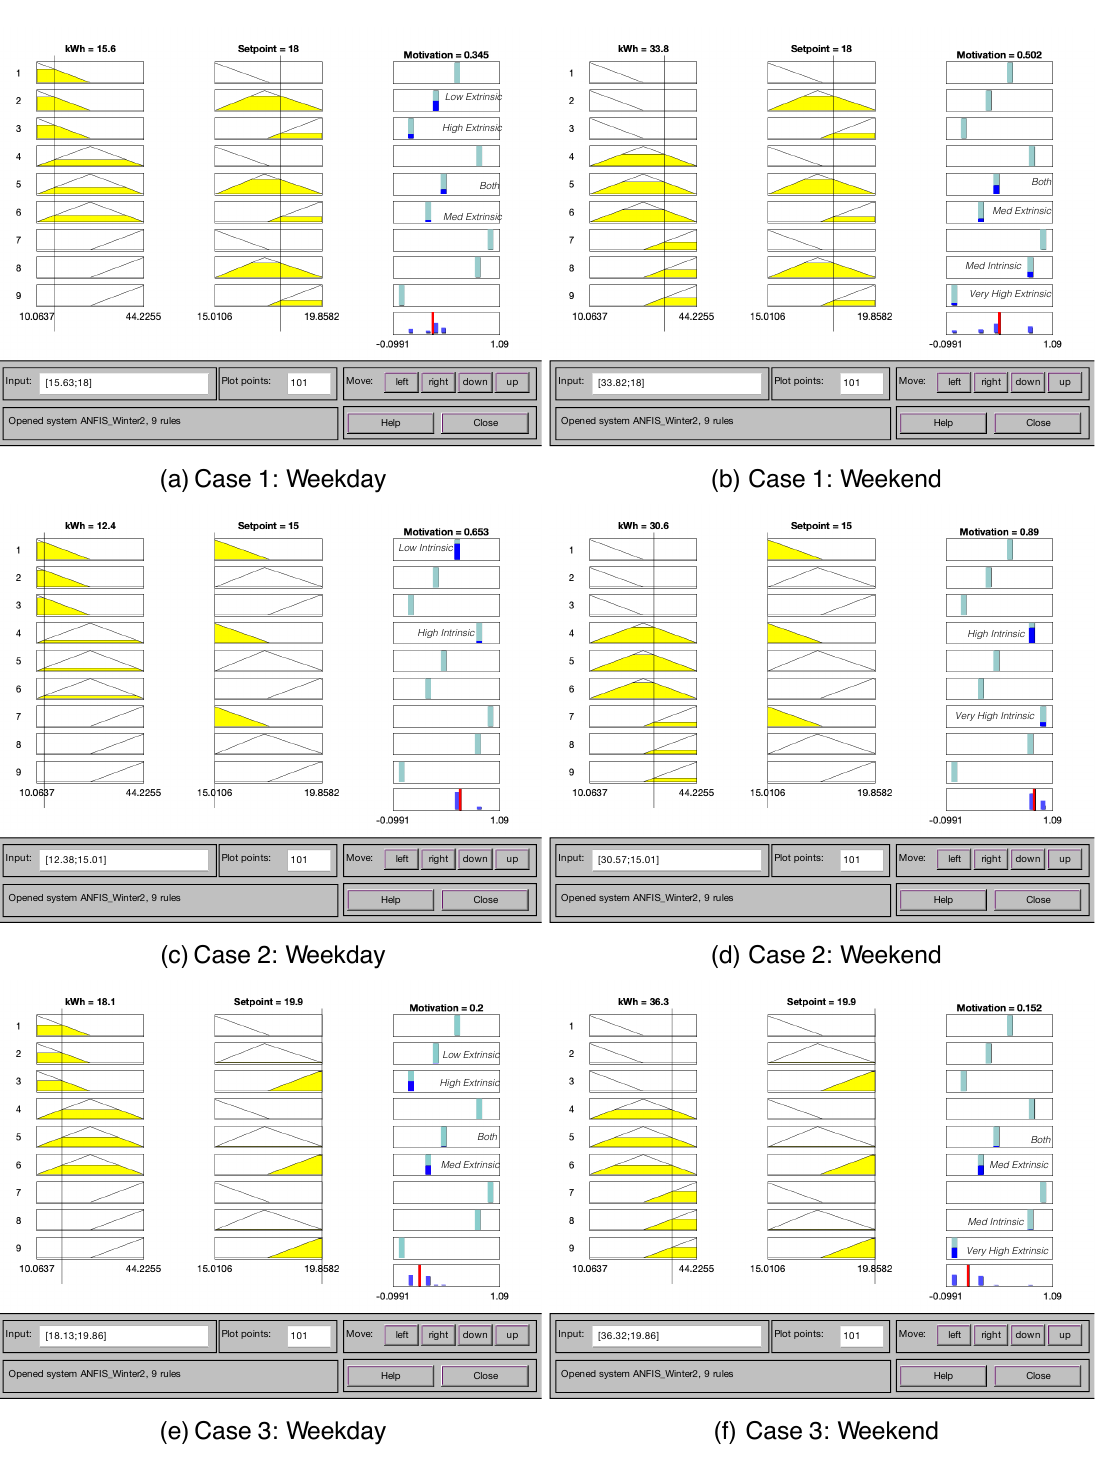
Figure 14. Neuro-fuzzy rules for winter